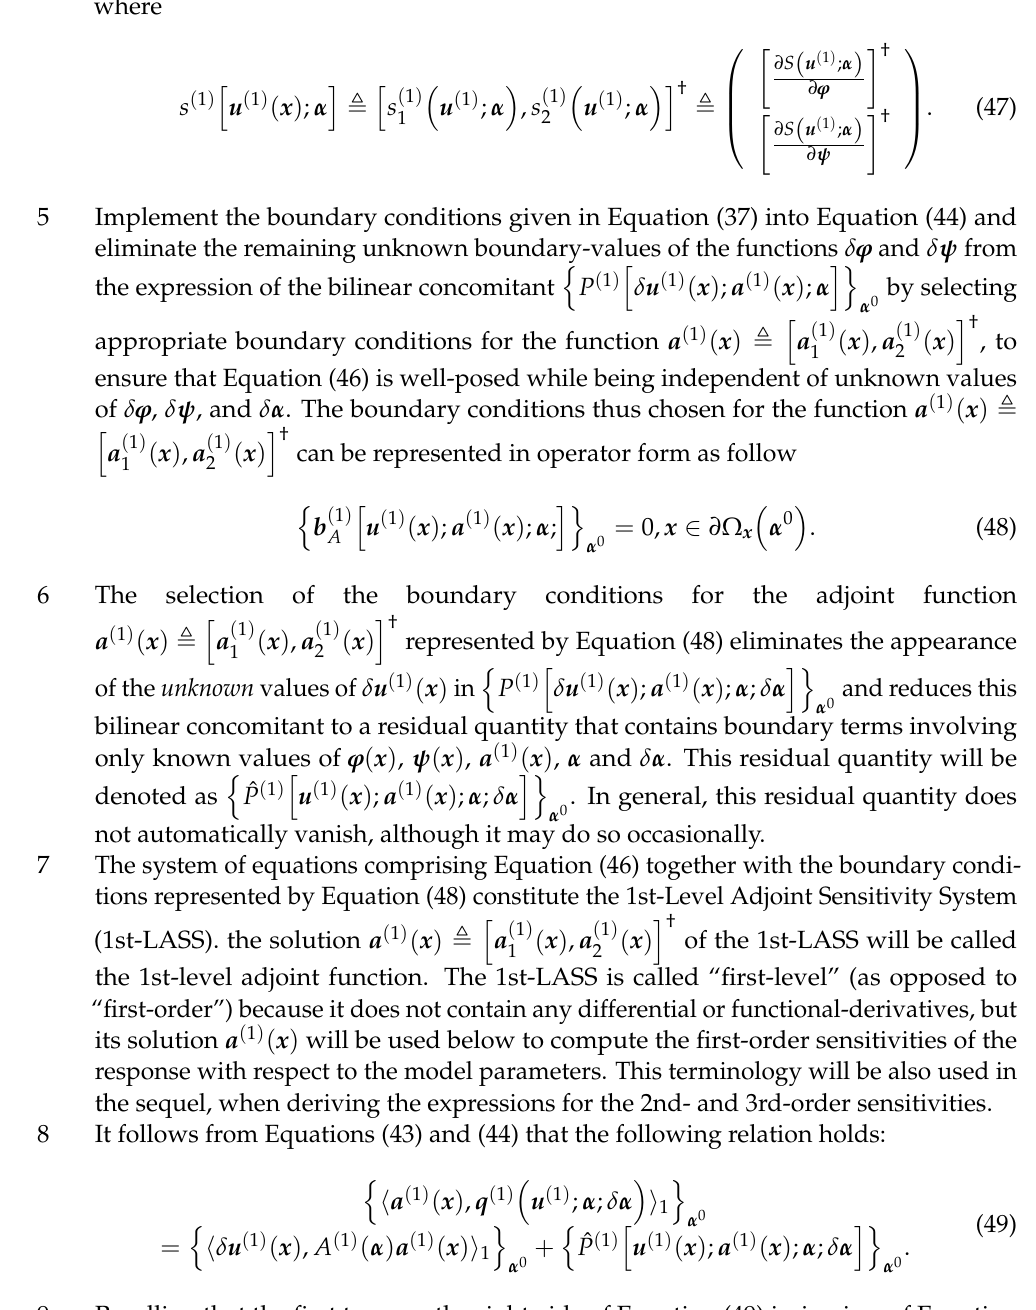
(cid:110) (cid:104) (cid:105)(cid:111) P ( 1 ) δ u ( 1 ) ( x ) ; a ( 1 ) ( x ) ; α by selecting α 0 (cid:105) † (cid:104) ( 1 ) ( x ) ( x ) , a ( 1 ) a , to 2 1